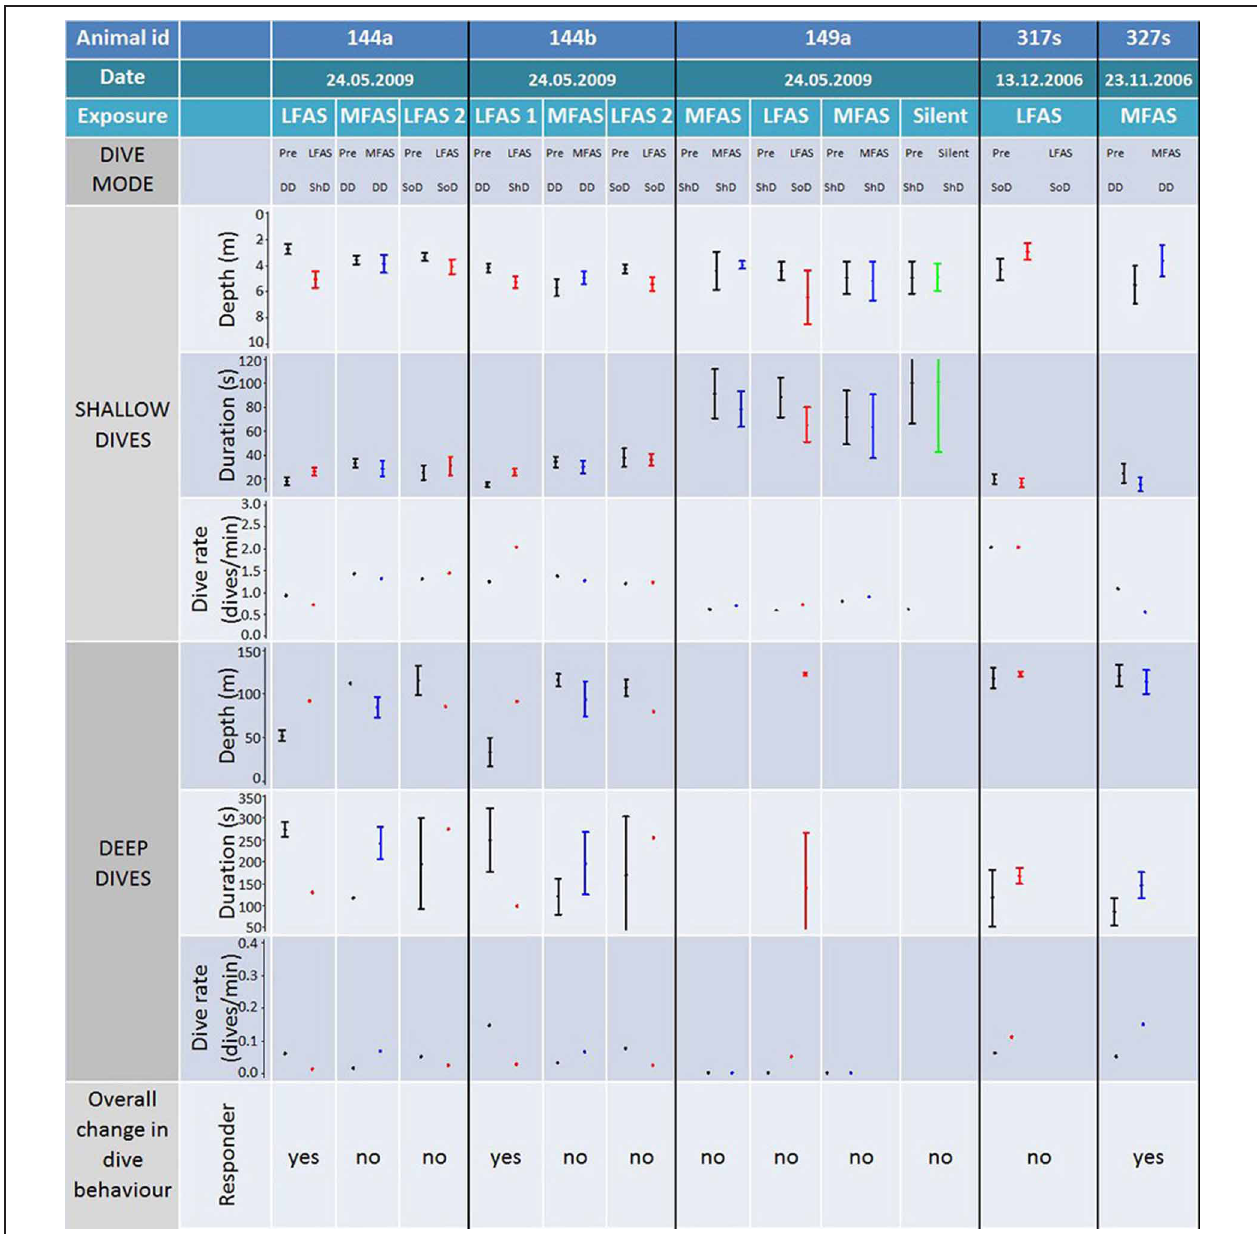
deep dive (SoD). Bars show the 95% confidence interval. Dive rate for deep and shallow dives are number of dives in the PRE/Exposure period divided on the duration of the period, given as dives/min. All individual exposure sessions are classified either as a “responder” or not, based on the combined comparison of the depth, duration rate, and mode of the PRE and Exposure